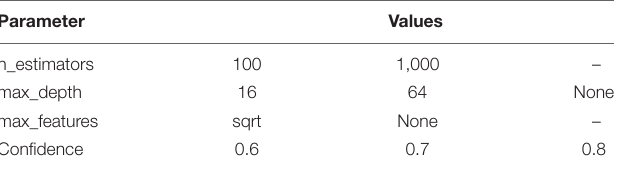
TABLE 1 | Parameter values used for computationally intensive grid search on animal-distal-gut samples.